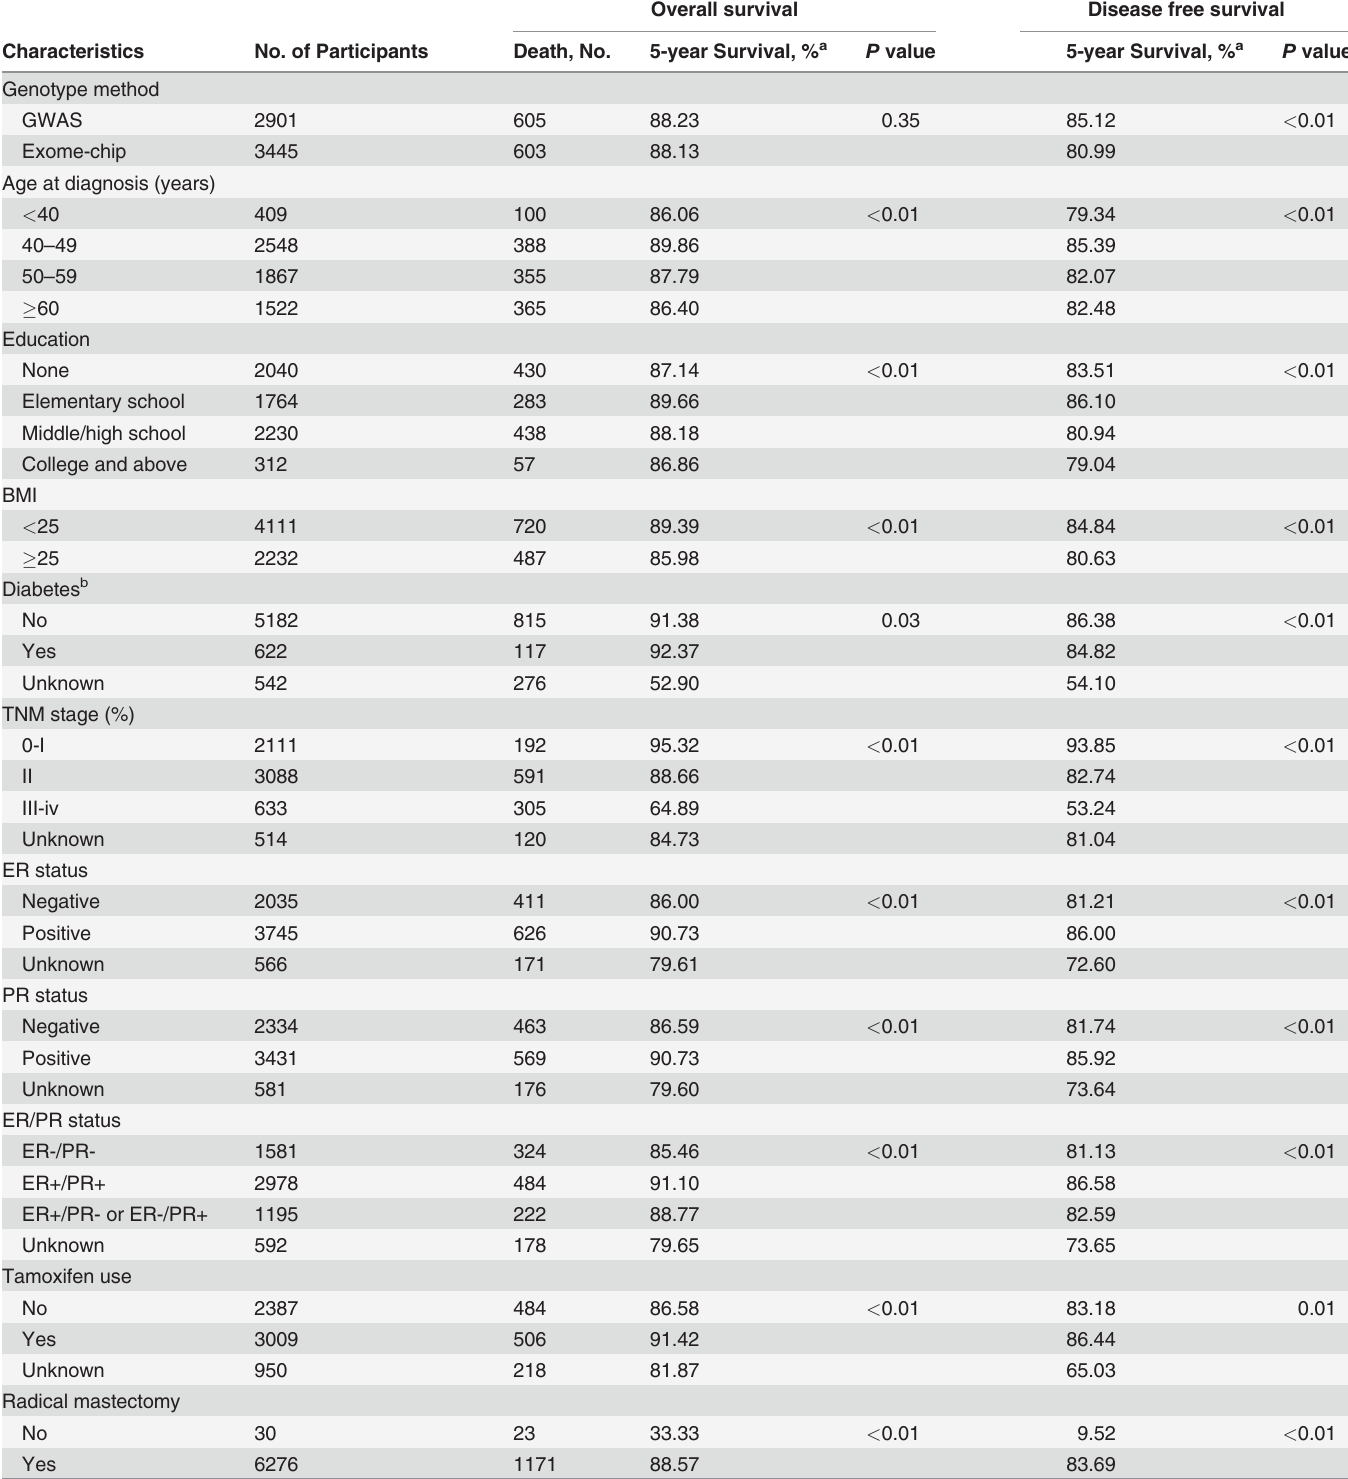
Table 1. Participant demographic and clinical predictors for breast cancer survival. Overall survival Disease free